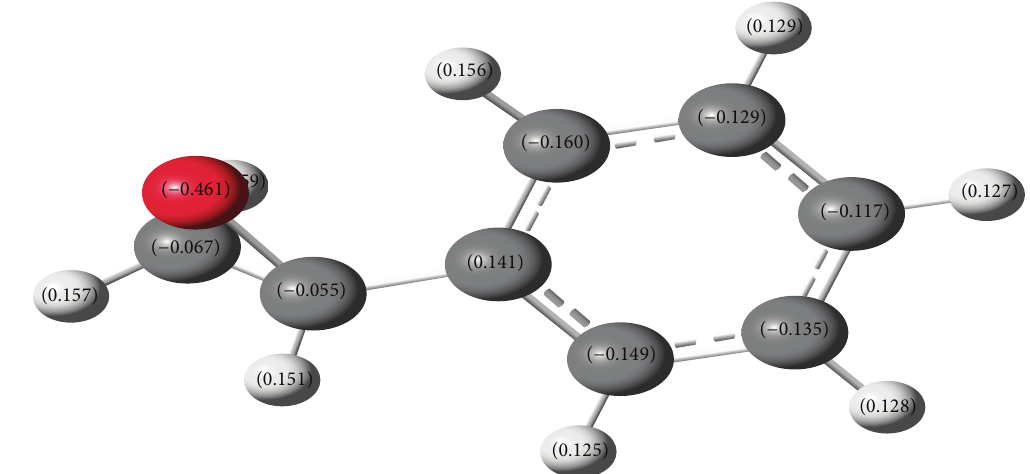
Figure 11: Geometry of styrene oxide showing atomic charges (Coulomb).